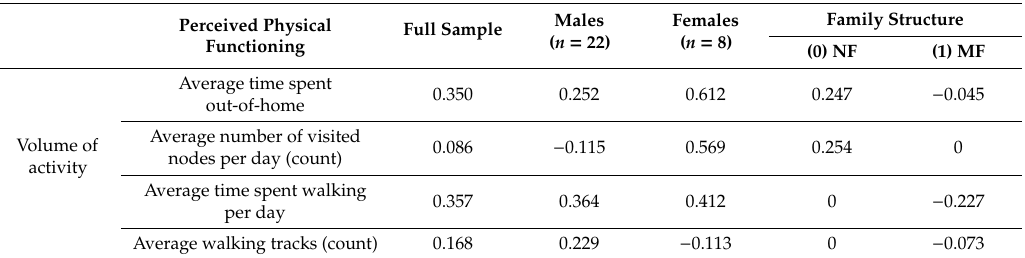
Table 6. Bivariate Correlation (Spearman correlation) between Perceived Physical Functioning (Health problems) and Spatial